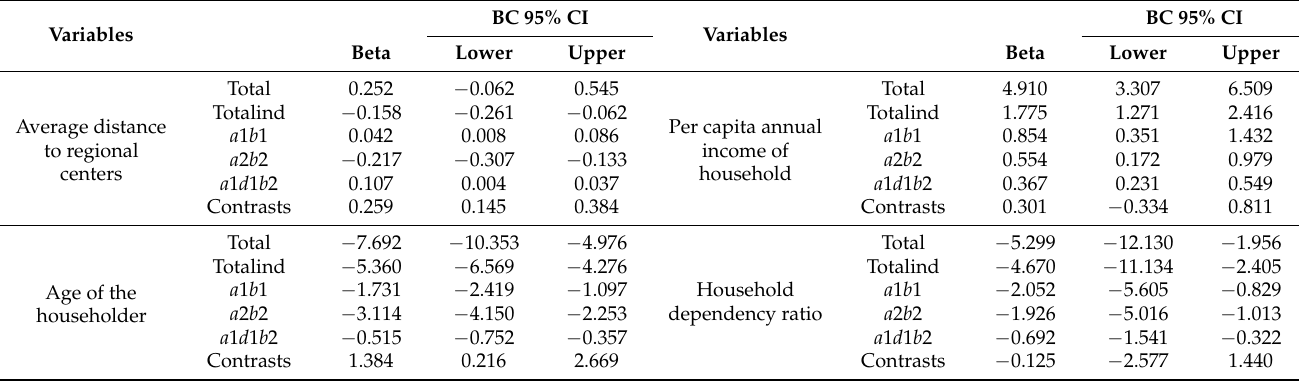
Table 5. Results of multiple mediation analysis of the relation between household characteristics, livelihood and accessibility of rural life space.